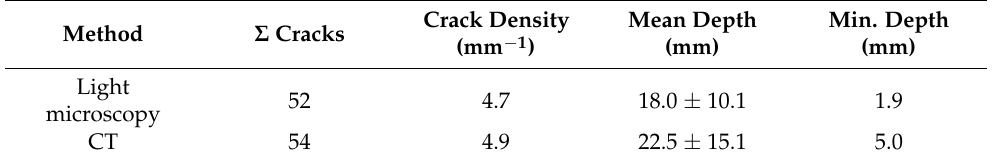
Table 3. Characteristics of secondary cracks in an 11-millimeter-long surface section of the cracked